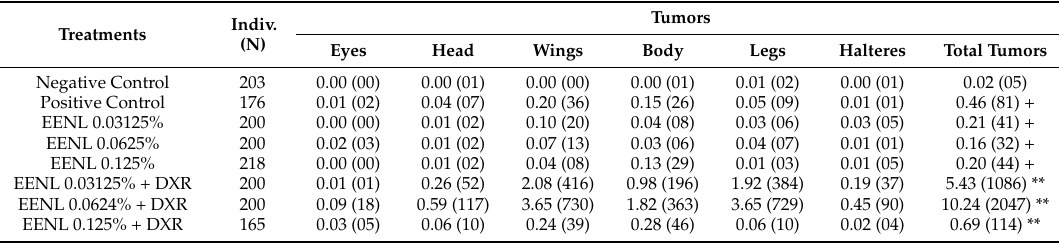
Statistical diagnosis according to the Mann–Whitney U -Test. Level of significance P ≤ 0.05. + value considered statistically different from the negative control ( P ≤ 0.05). ** value considered statistically different from the positive control (DXR 0.4 mM) ( P ≤ 0.05). DXR = doxorubicin (0.4 mM). EENL =